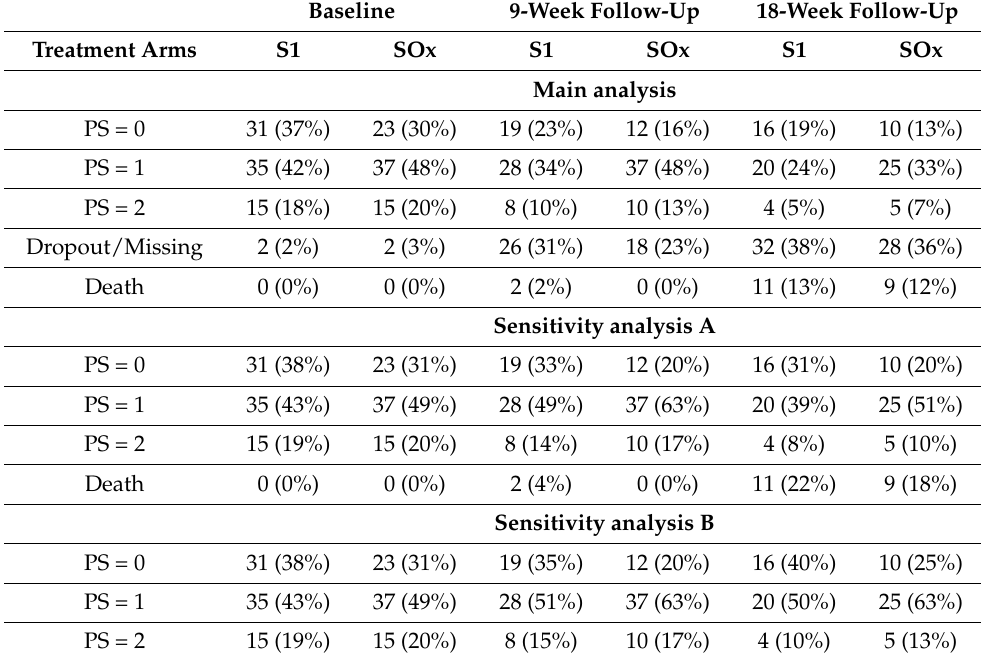
Table 5. ECOG PS at baseline, at 9-week and at 18-week follow-ups per treatment groups indicated as counts and proportions. The sensitivity analyses with different imputation choices allowed utilization of data in incomplete